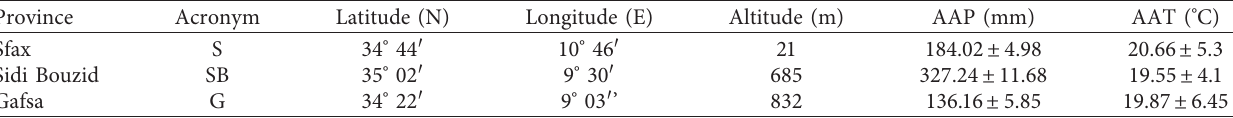
Table 1: Geographic characteristics and climatic conditions of different pistachio ( Pistacia vera L.)